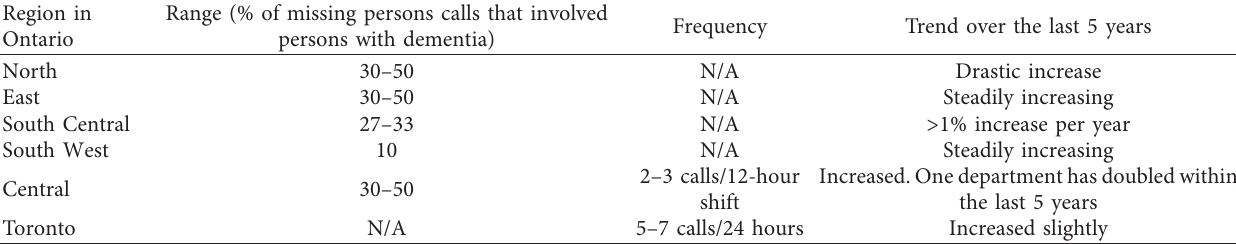
Table 5: Trend of calls about missing persons with dementia, by